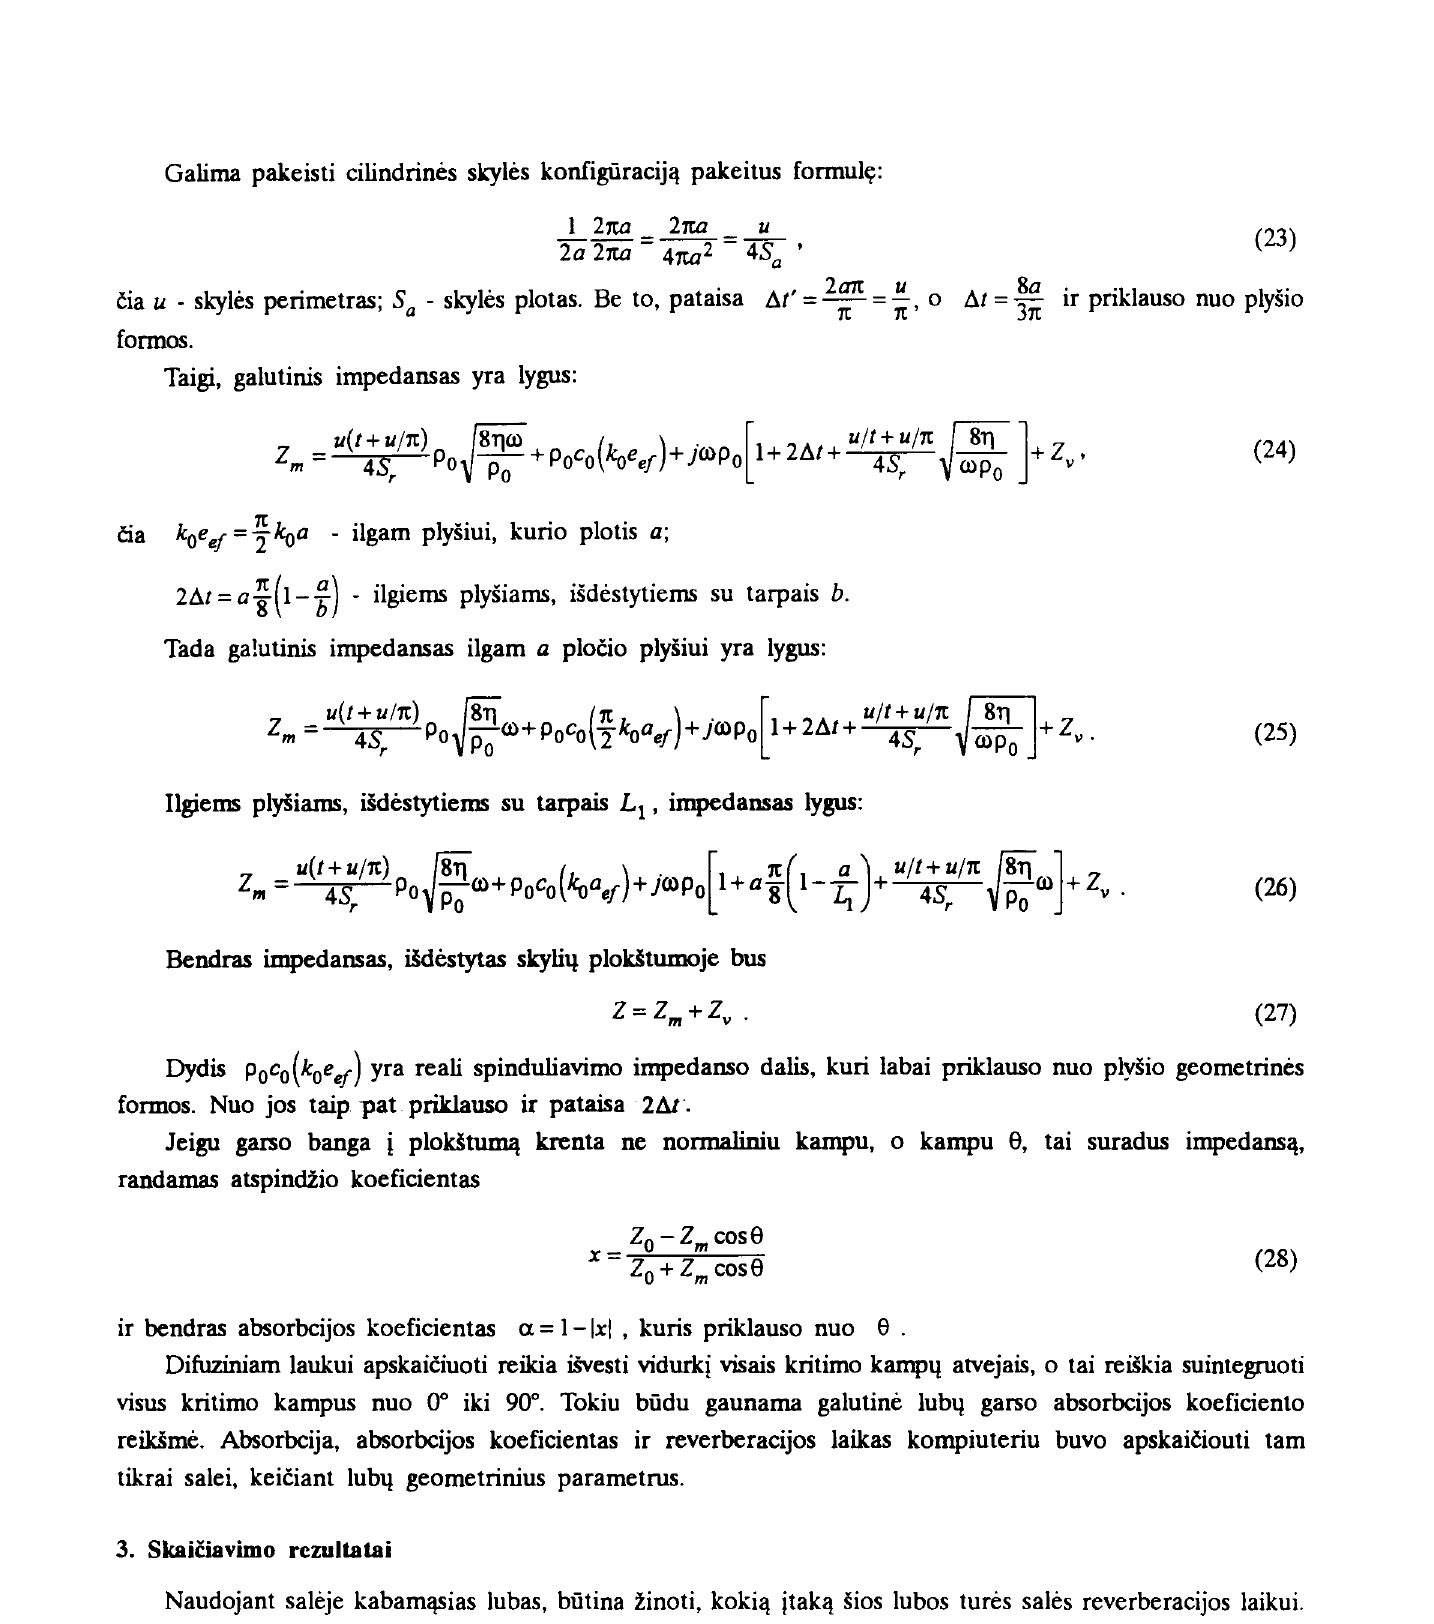
impedansas lygus: 1 ,